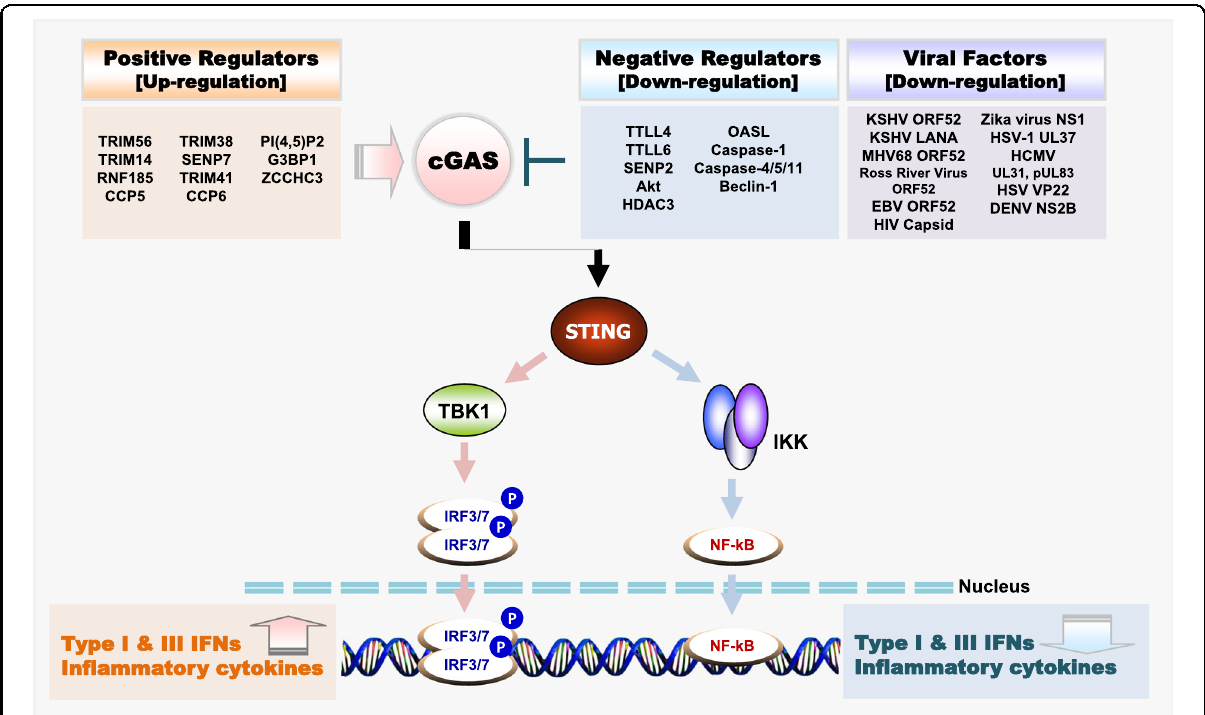
Fig. 2 Regulators and interacting viral proteins of the cGAS – STING antiviral signaling pathway. Schematic presentation of positive and negative regulators of cGAS through PTMs or non-PTMs and immune invasion viral proteins interacting with cGAS. cGAS induces signaling through the adapter protein STING, resulting in dimerization of STING and activation of the transcription factors NF- κ B and IRF3/IRF7 via cytosolic kinases IKK and TBK1, respectively. Activated transcription factors NF- κ B, IRF7, and IRF3 translocate to the nucleus and induce transcription of type I IFN and pro- in fl ammatory